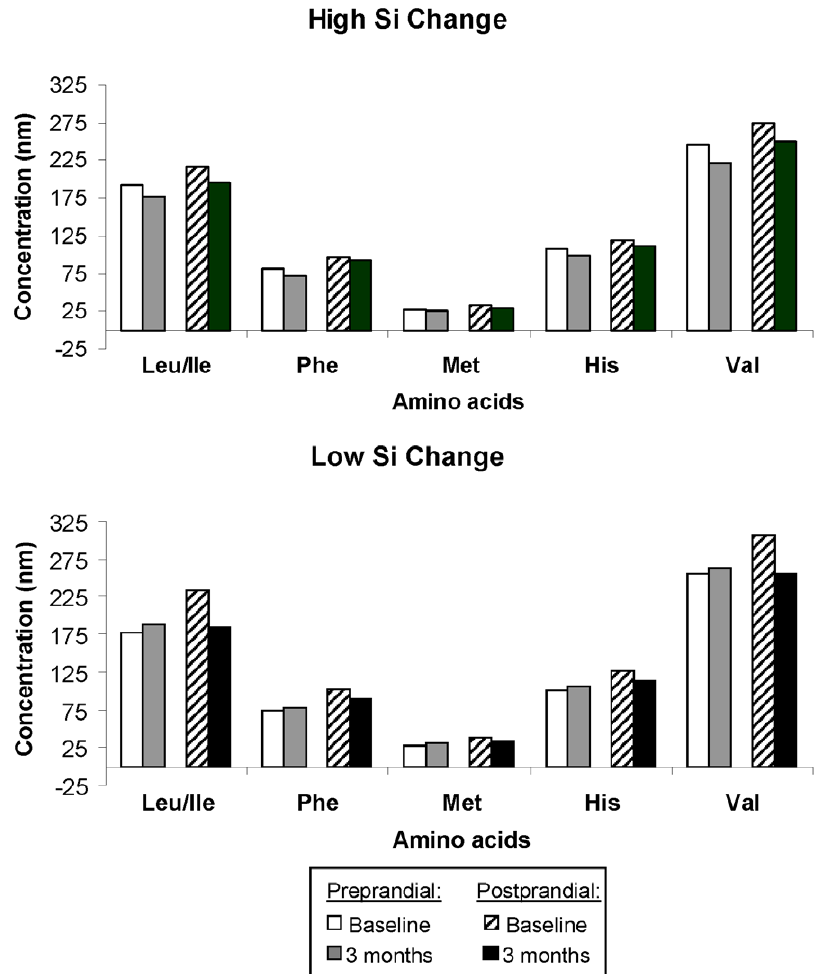
Figure 6. Preprandial and postprandial concentrations of amino acids for those with the highest and lowest insulin sensitivity changes. Baseline and three month amino acids concentrations are shown for both fasting (preprandial) and postprandial assessments. The five amino acids that had the largest loadings on the amino acid factor (see Table 1) are shown. Leu/Ile=leucine/isoleucine, Phe=phenylalanine, Met=Methionine, His=Histidine, Val=Valine.